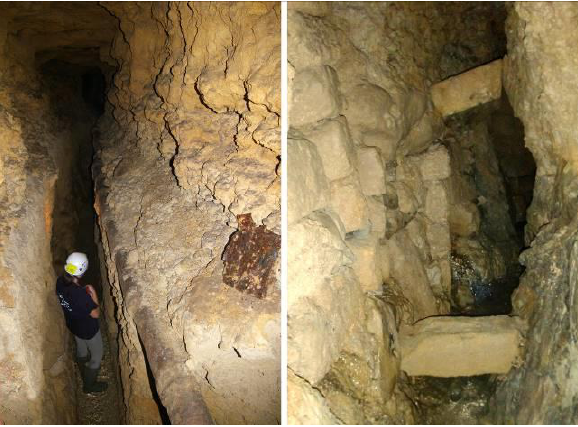
Figure 5 . The geometric-formal complexity of the site (Photographic archives CAI Palermo Speleological Group).